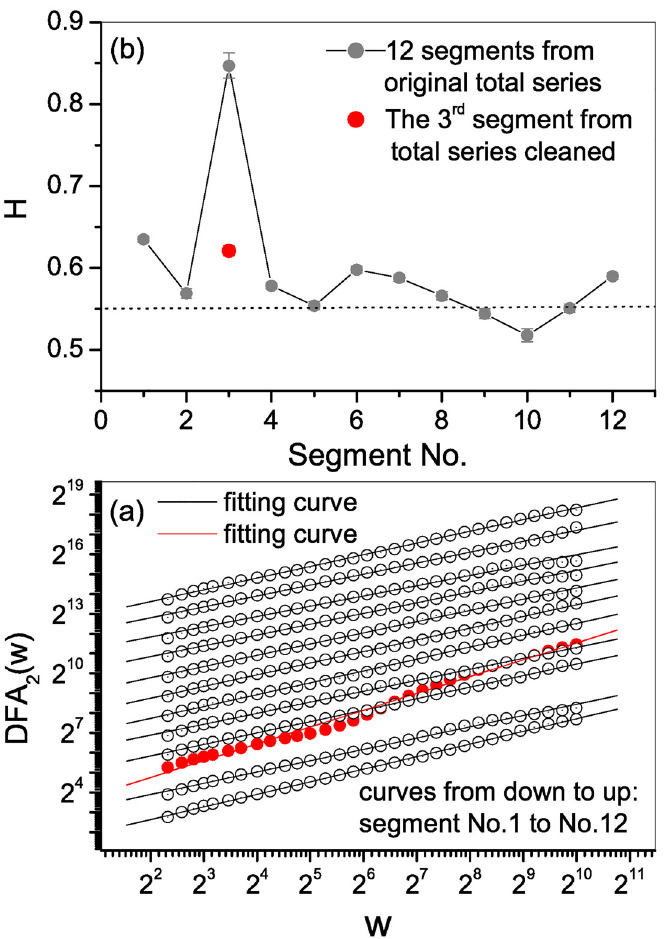
Fig 3. Structural stability test. The total polluted series was separated into 12 non-overlapping segments with a length of 2881. (a) All the curves obey almost perfect power-law relationships (gray open circles), except the 3rd segment which deviates significantly (red solid circles). (b) Hurst exponents for the 12 segments. The unreasonable large value of 0.87 for the 3rd noisy segment was corrected to 0.621 (red solid circle) after applying the cleaning procedure. There is a slightly decreasing